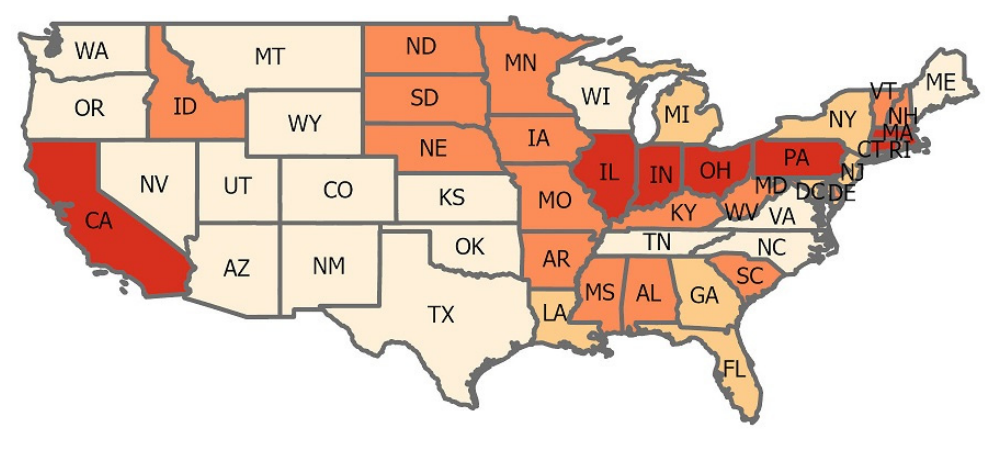
Figure 4. Map showing a comparison of the average number of COVID-19 deaths in nursing homes to the average number of COVID-19 deaths in each respective state.